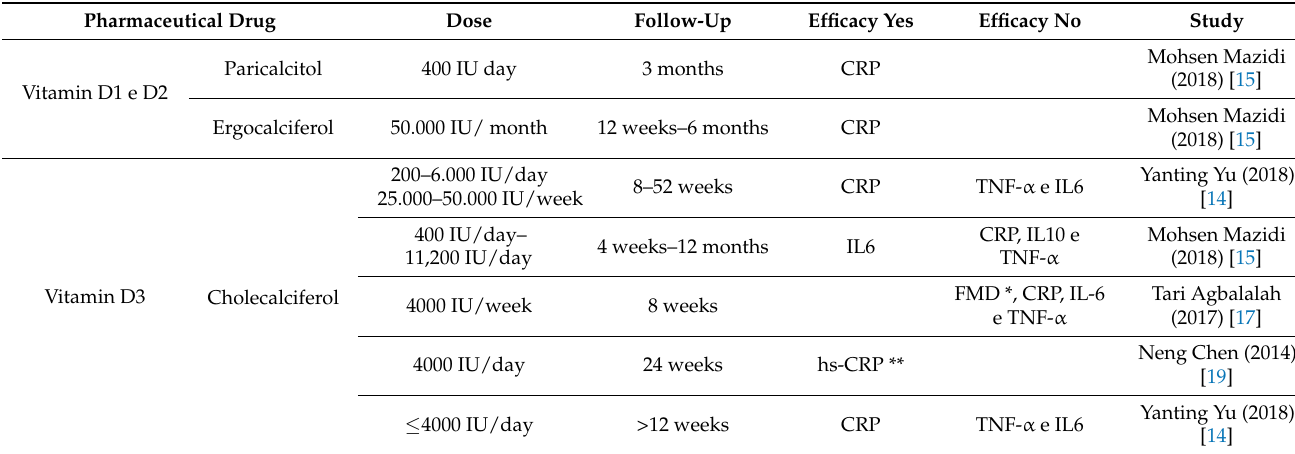
Table 2. Vitamin D: summary of the principal characteristics of the included systematic reviews.